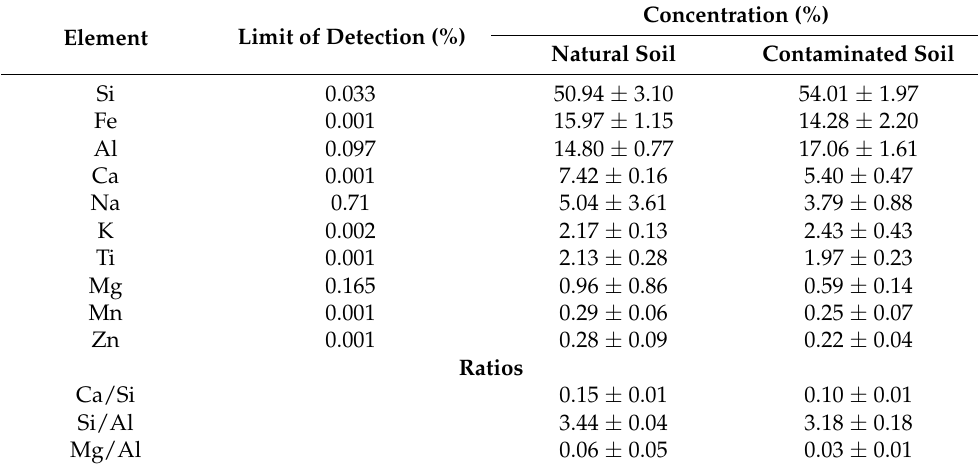
Values in the table: mean value ± standard deviation ( n = 3).